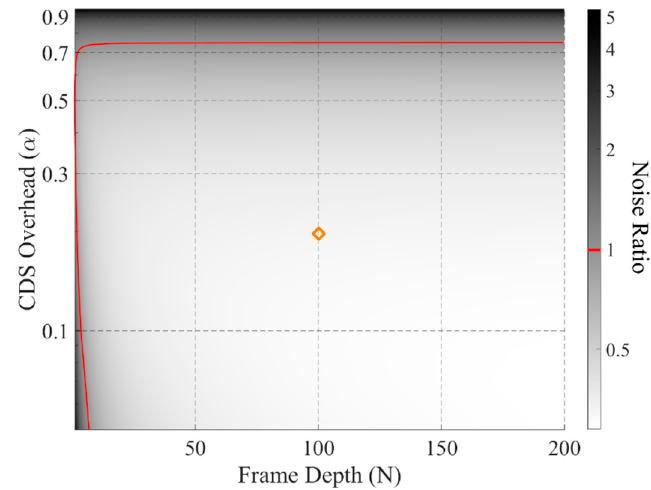
Figure 2. Noise power ratio between the in-pixel correlated double sampling (CDS) case and the conventional case as a comparison. E.g., given α = 0.2, N = 100, the ratio is 0.325 as highlighted, which means there is 67.5% noise reduction in the in-pixel CDS case compared to the conventional case.